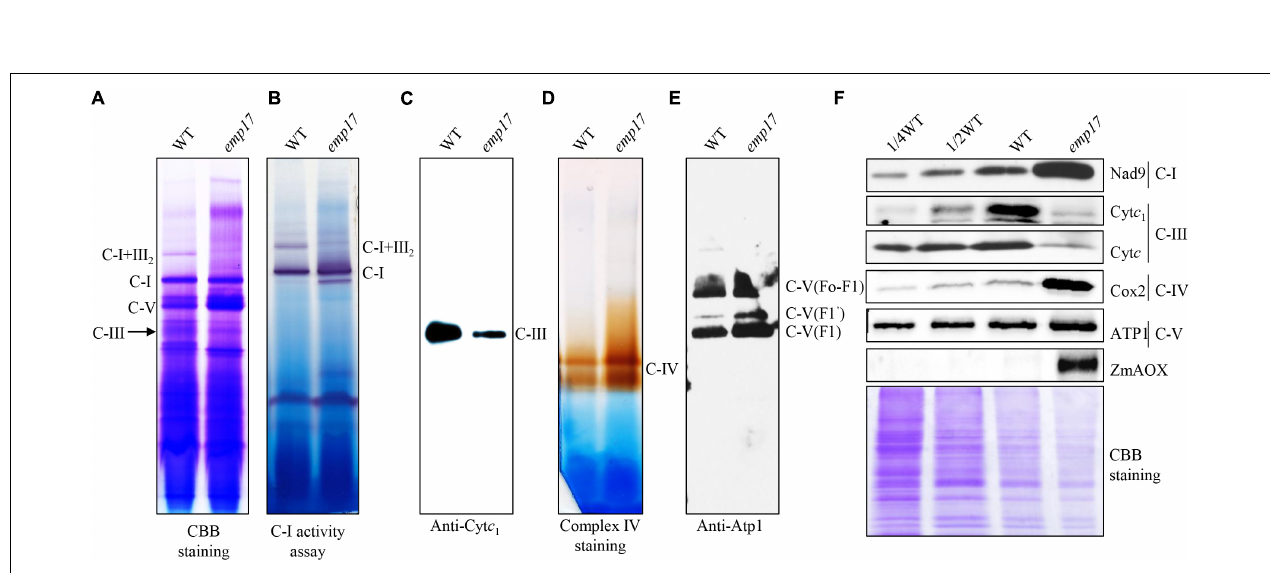
FIGURE 6 | Mutation of Emp17 compromises the assembly of the mitochondrial complex III and supercomplex I + III 2 . (A) Blue native-PAGE (BN-PAGE) analysis of the assembly of complex I and supercomplex I + III 2 . The gel was stained with Coomassie Brilliant Blue (CBB). (B) In-gel staining of the nicotinamide adenine dinucleotide (NADH) dehydrogenase activity of complex I and supercomplex I + III 2 . The loading control is Dihydrolipoamide dehydrogenase (DLDH) activity. (C) Western blotting assay based on antibodies against Cyt c 1 (complex III). (D) In-gel activity staining of mitochondrial complex IV. (E) Western blotting assay based on antibody against Atp1 (complex V). (F) Western blotting assay with antibody against Nad9, Cyt c 1 , Cyt c , Cox2, Atp1, and ZmAOX. CBB staining was used for loading control. C-I: complex I, C-III: complex III, C-I + III 2 : supercomplex I + III 2 , C-V: complex V.